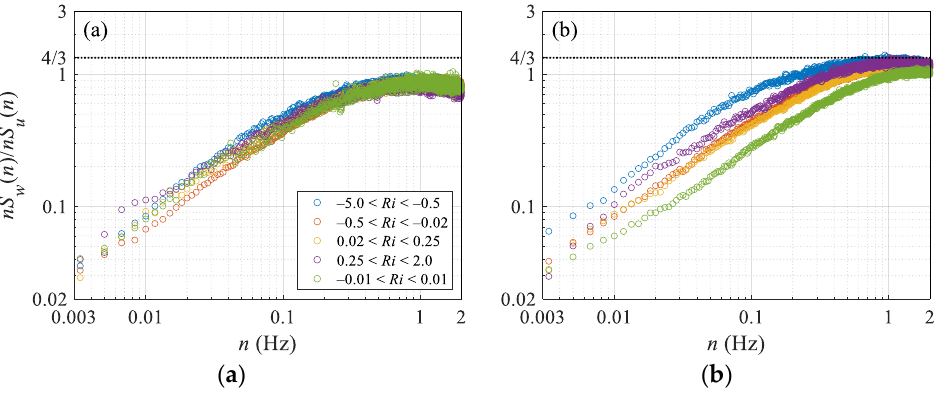
Figure 10. Ratio of vertical velocity spectral density S w ( n ) to longitudinal velocity spectral density S u ( n ) for different stability ranges the directions of northwest ( a ) and southeast ( b ).